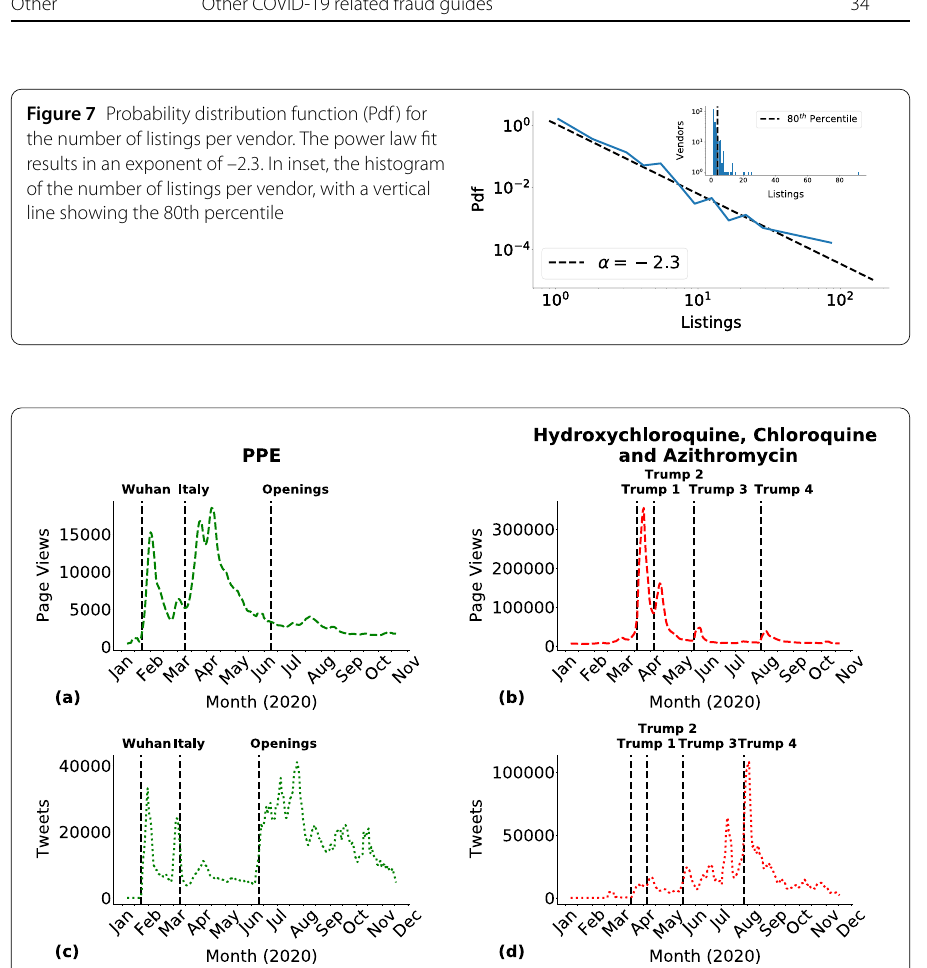
Figure 8 Time evolution of the active COVID-19 specific listings in the guidesonscamming category. ( a ) Seven-days rolling average of these observed listings at a given time. Black dashed vertical lines corresponded to significant COVID-19 world events, see Appendix C. ( b ) Seven-days median price with 95% confidence interval for these observed listings